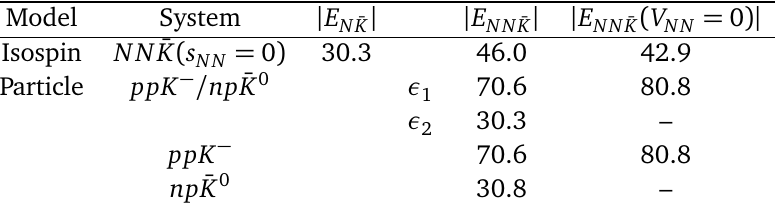
Table 2: The quasi-bound state energy | E lated within the isospin formalism and particle two-level system model with the AY ¯ KN and MT I-III nucleon-nucleon potentials. | E glet state of N ¯ K pair ( pK − or n ¯ K 0 ). The energies for the separated nn ¯ K 0 and npK − systems are presented. The values of | E two nucleons is turned off are shown. ε of nn ¯ K 0 / npK − state, respectively. The energies are given in MeV.